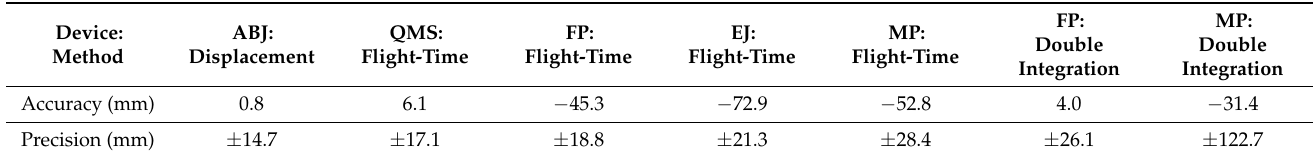
Table 1. The accuracy and precision of jump height when comparing different approaches to a QMS marker displacement method.